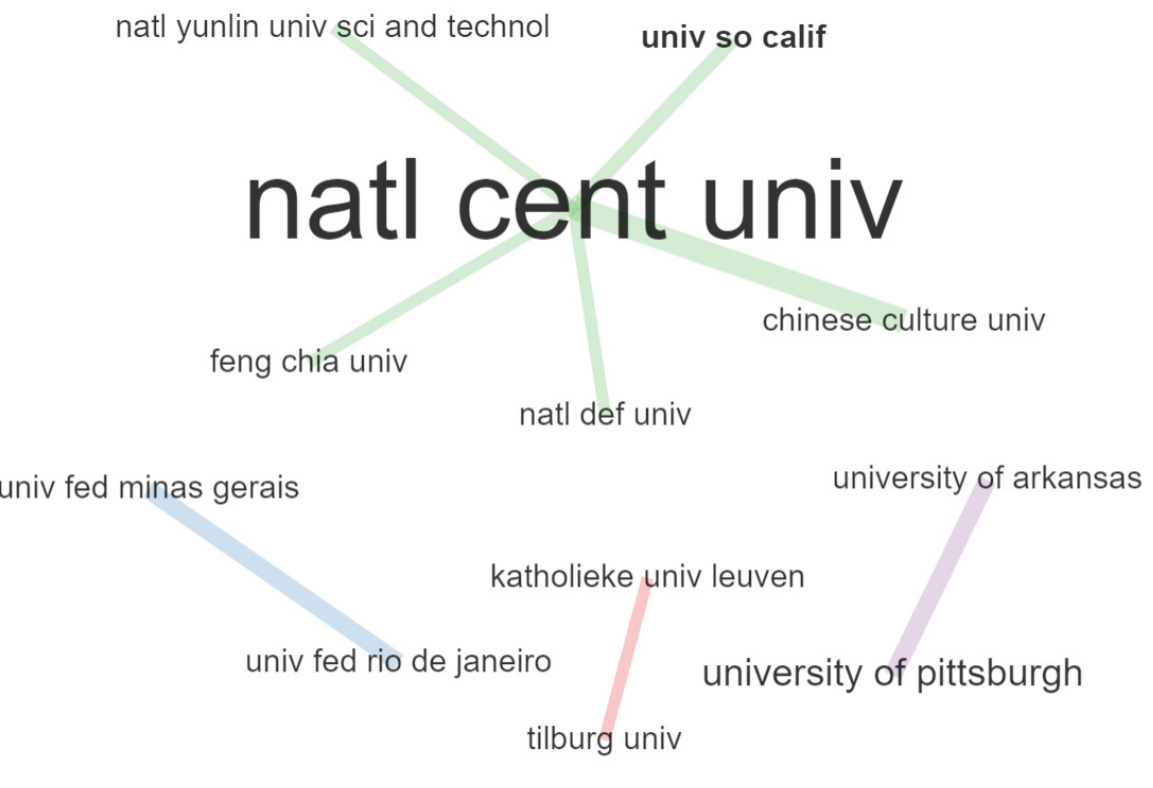
Figure 6. Authors network.